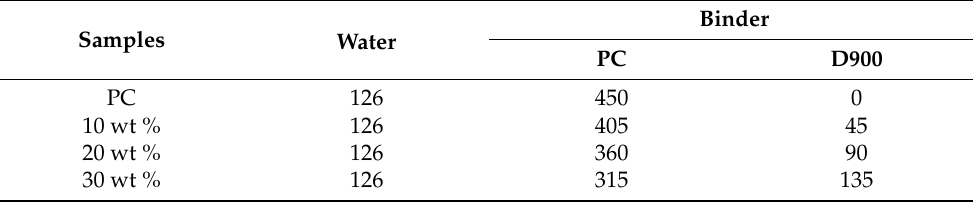
Table 2. Mix proportions of concrete